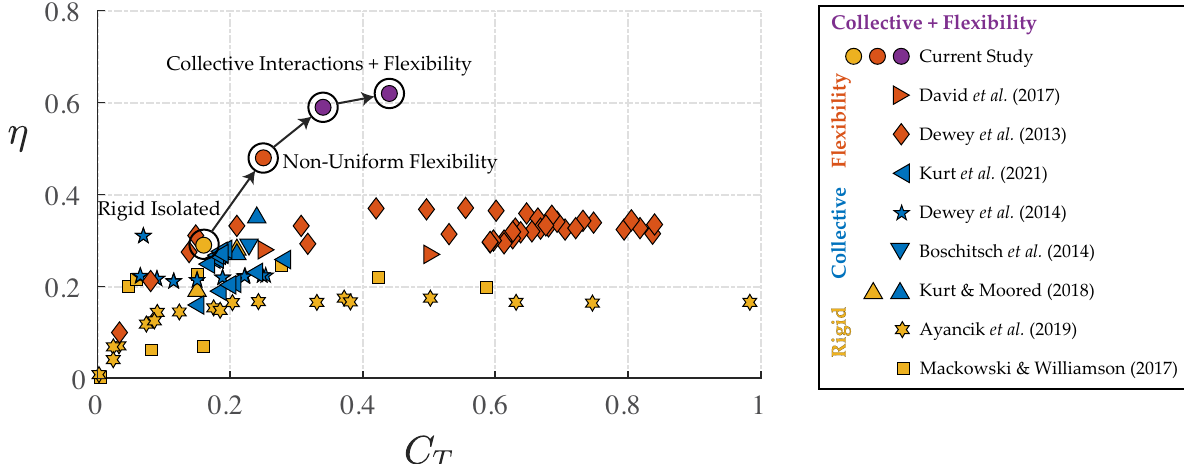
Figure 1. The current study charts a path to exceeding 60% collective efficiency while pitching foil studies typically never break 40% efficiency. The markers are colored yellow for single rigid foil studies, blue for studies of a pair of interacting rigid foils, red for single flexible foil studies, and purple for our current study where we examine a pair of interacting flexible foils. Not all data was extracted from each study. The highest efficiency cases were chosen for two-dimensional foils and three-dimensional foils with (cid:65) ≈ 2